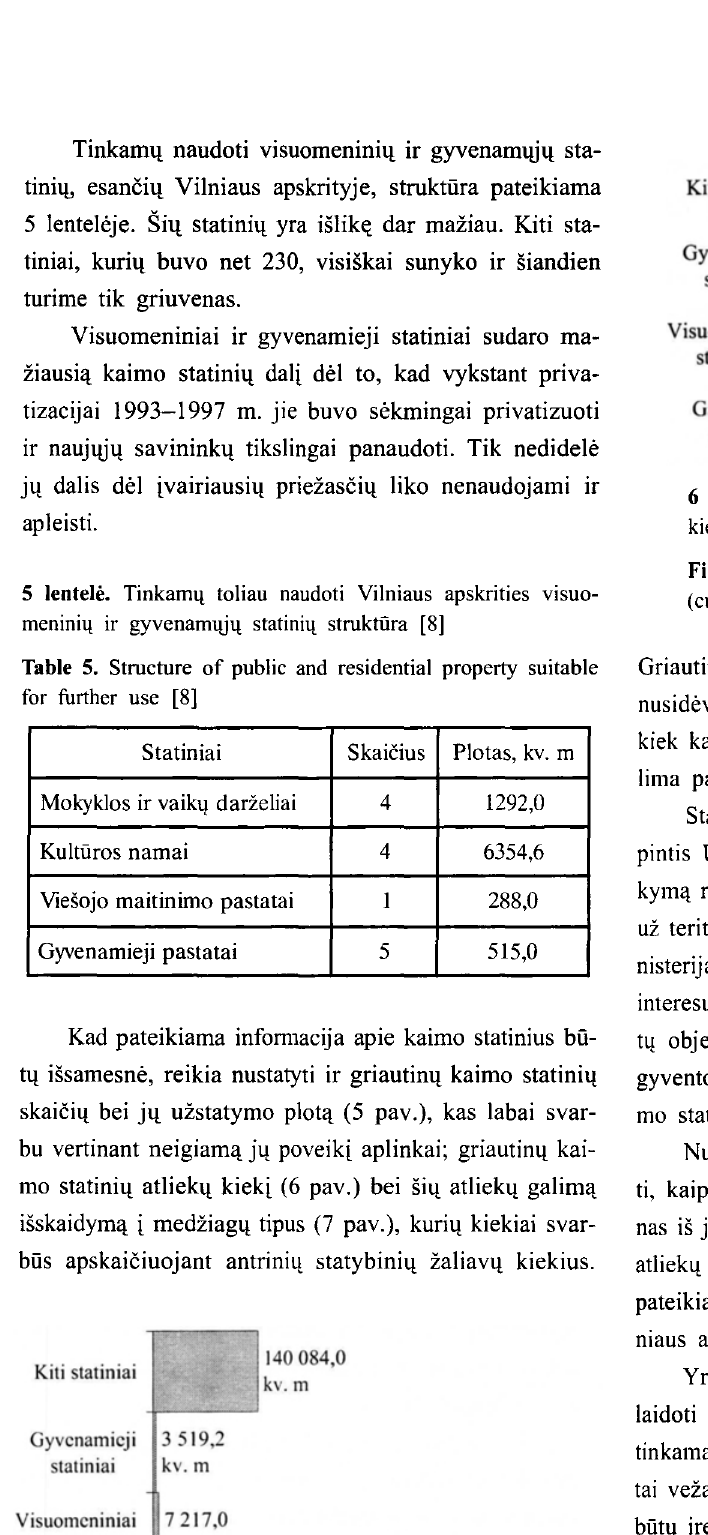
Fig 5. Areas of rural property to be demolished in Vilnius district (sq m) [8]